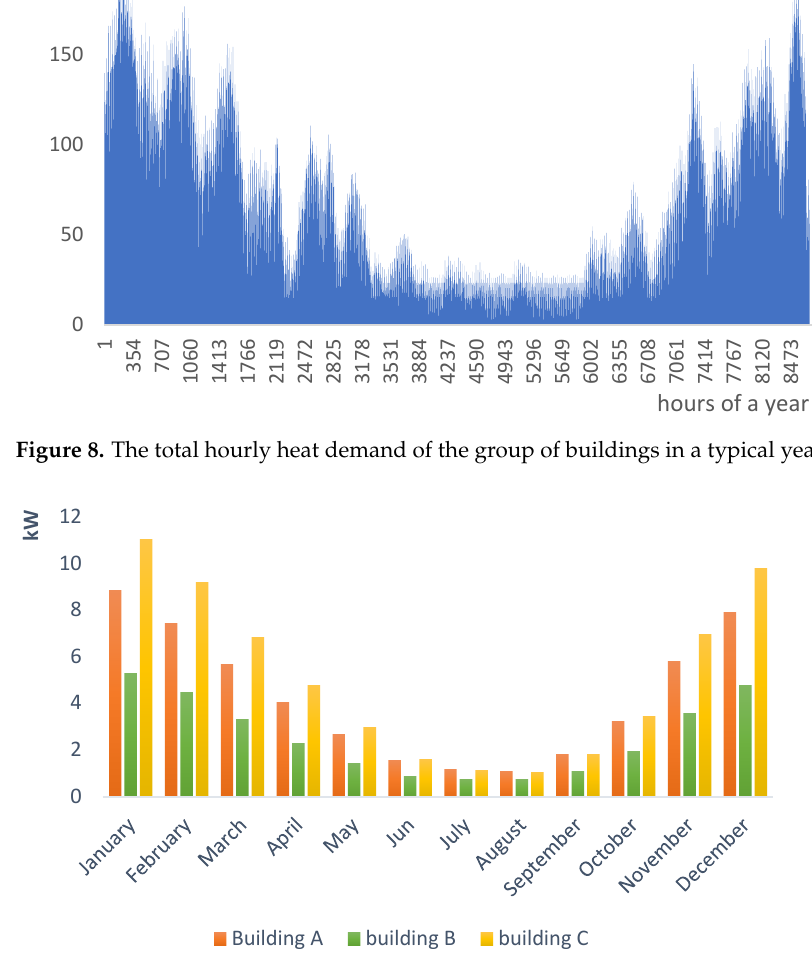
Figure 9. Comparison of heat demands in three different types of buildings.